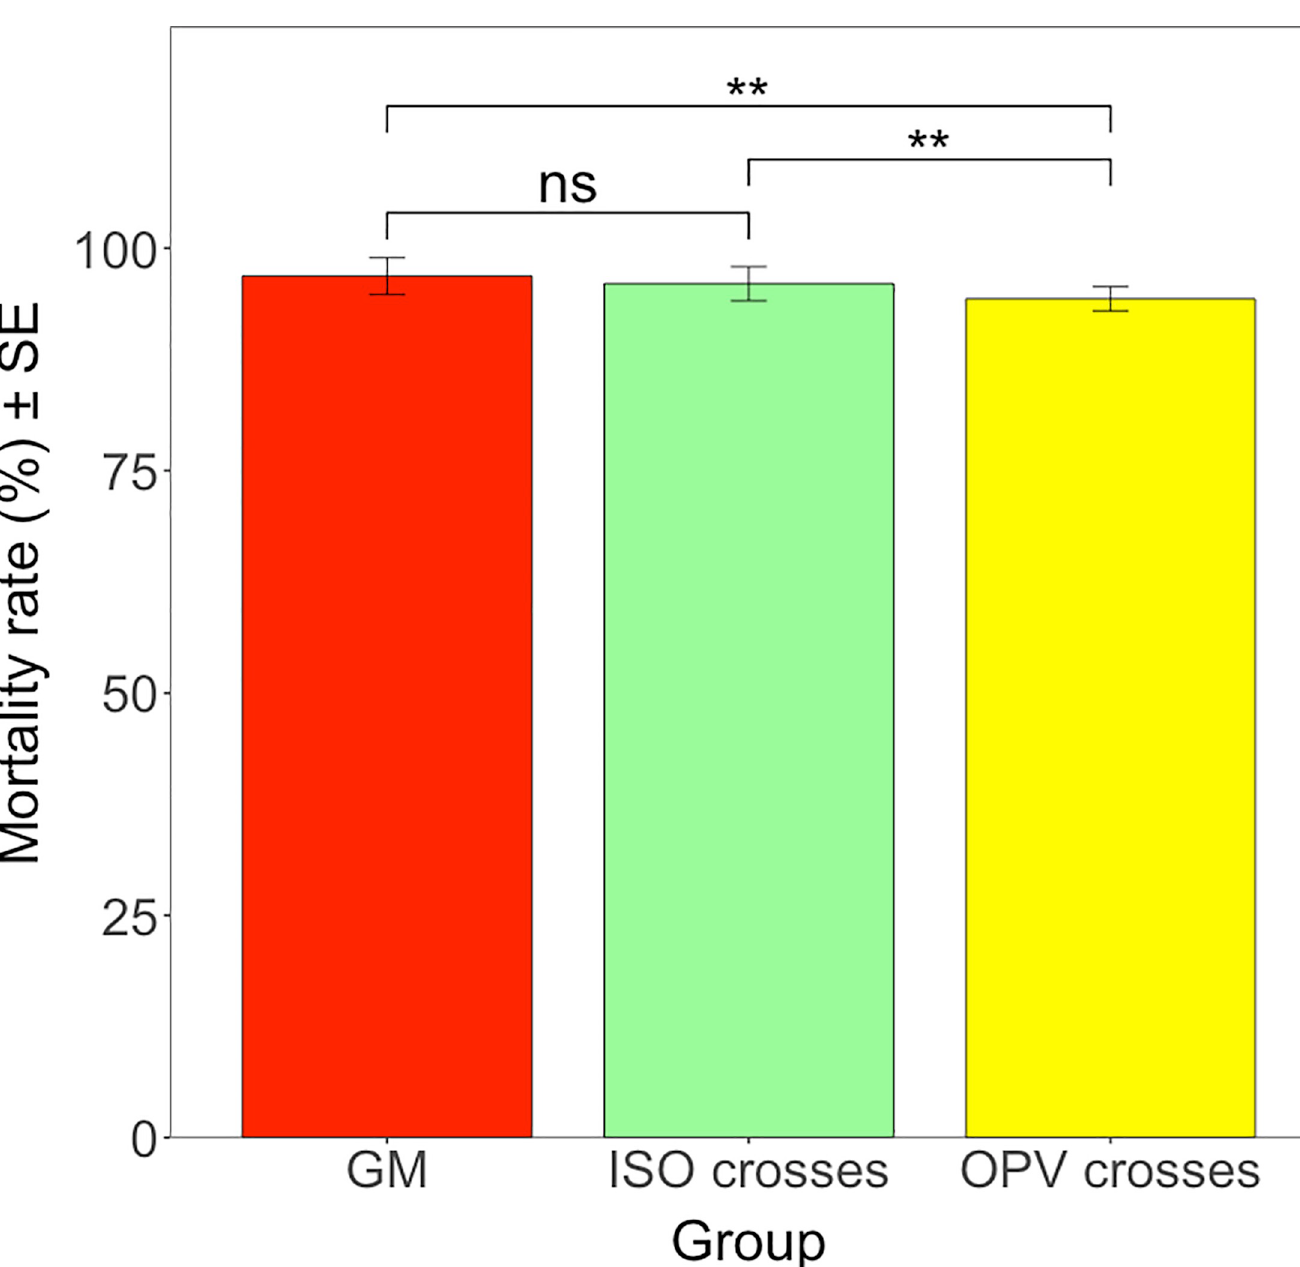
Brazil and South Africa, respectively (S9 and S10 Tables). Similarly, Erasmus et al. [13], using these same African genetic backgrounds but a different lepidopteran species, reported a lack of correlation between Cry1Ab concentration and Busseola fusca survival. Erasmus et al. [13] concluded that the effect that transgene flow to OPVs may have on resistance evolution was overestimated.